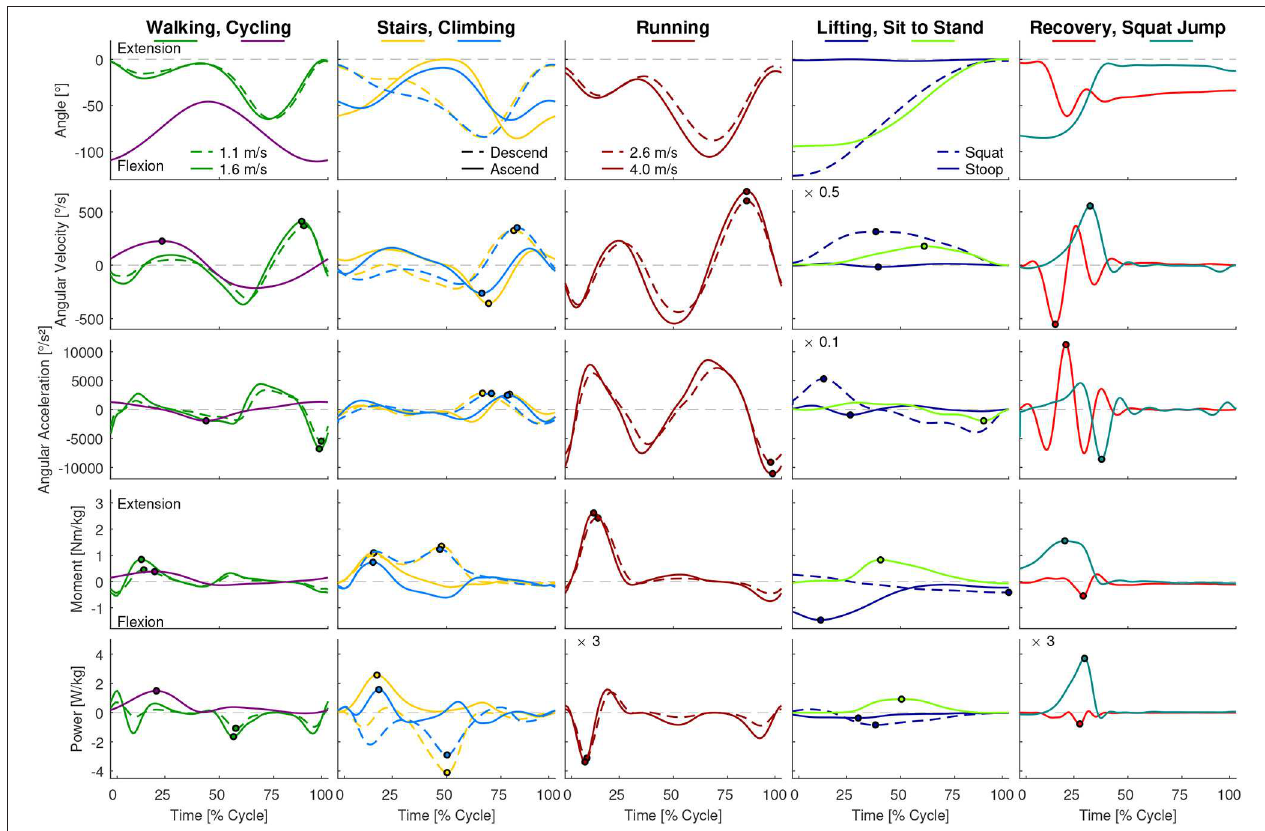
FIGURE 8 | Knee angle, angular velocity, angular acceleration, moment and power for all analyzed movements. Dots indicate the maxima used for Figures 2 , 4 . For visibility some of the graphs were scaled with a factor, which is located at the top left of these graphs. For example, a scaling factor of 0.1 indicates that the y-axis must be multiplied by